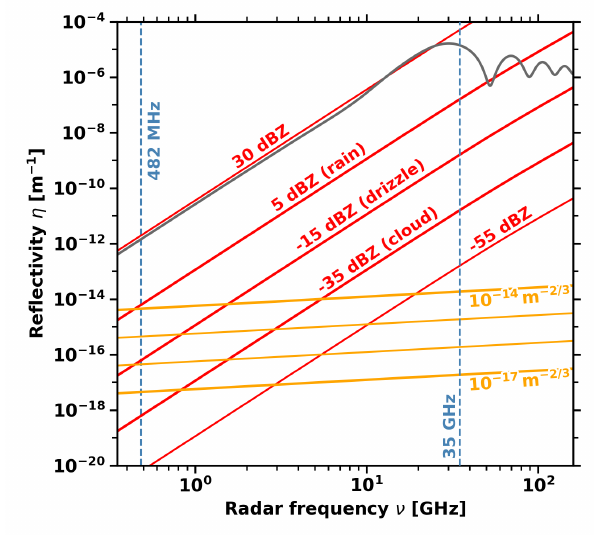
Figure 2. Reflectivity of different scattering processes (following Gossard and Strauch, 1983; Ralph, 1995). Red lines indicate typi- cal values of hydrometeor reflectivity with the sensitivity threshold of the cloud radar at − 55dBZ (Görsdorf et al., 2015). Orange lines indicate the reflectivity for C 2 n typically observed in the atmosphere (e.g. Clifford et al., 1994). The grey line shows the reflectivity of one liquid drop ( N = 1m − 3 ) with a diameter of d = 3mm as de- rived from Mie theory.